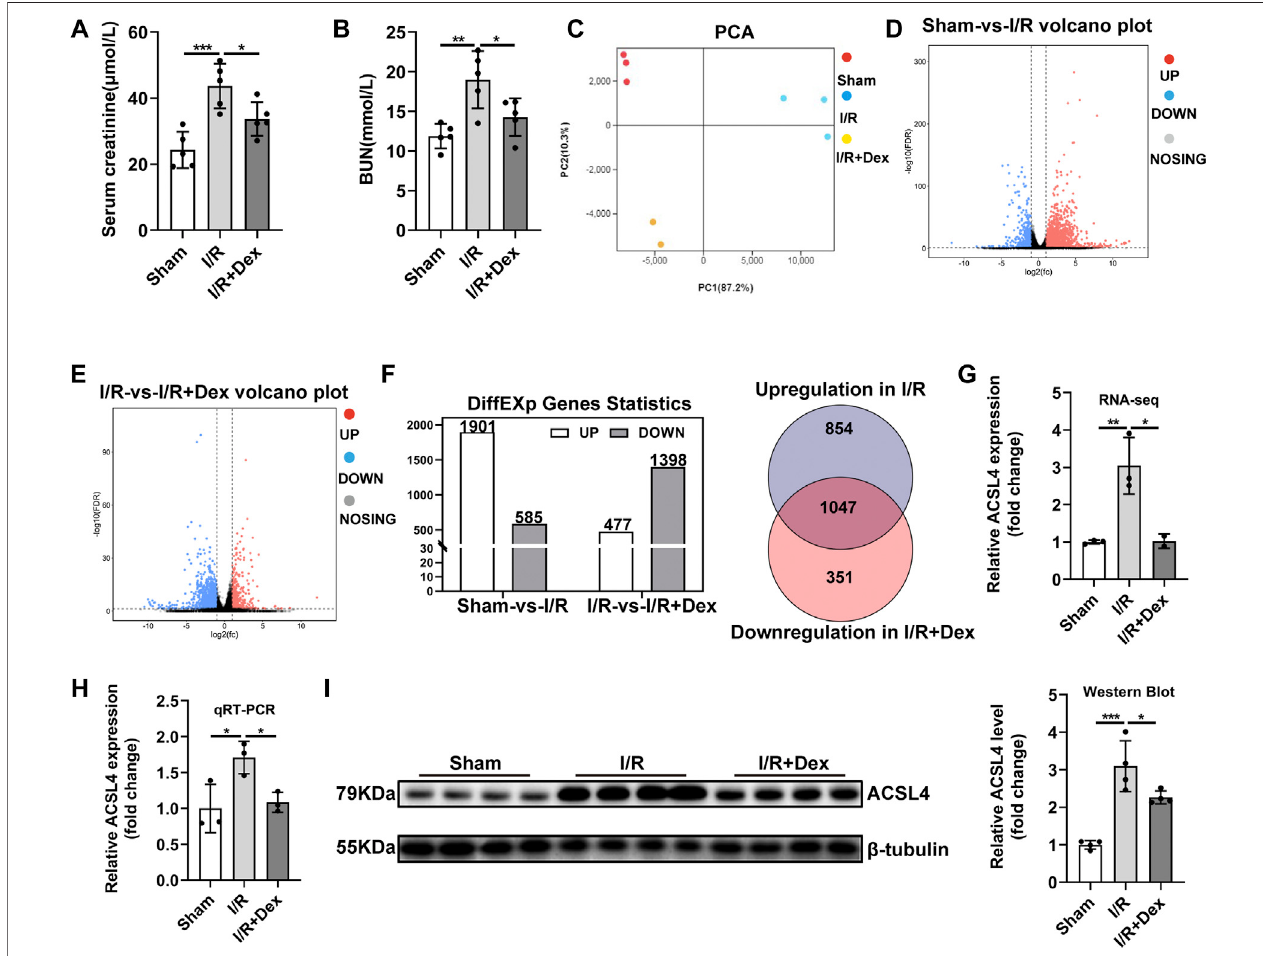
FIGURE 1 | Dex administration improved renal function and reversed ACSL4 upregulation during renal I/R. (A,B) The Scr and BUN levels for assessing renal function ( n = 5). (C) Principal component analysis (PCA) was performed. (D – F) Different expression genes statistics ( ǀ log 2 FC ǀ > 1, and FDR < 0.05). (G) Expression of ACSL4 gene in renal I/R tissue determined by RNA-sequencing (RNA-seq) ( n = 3). (H) ACSL4 mRNA expression (n = 3). (I) ACSL4 protein expression ( n = 4). The data are the Means ± S.D., * p < 0.05, ** p < 0.01, *** p < 0.001.